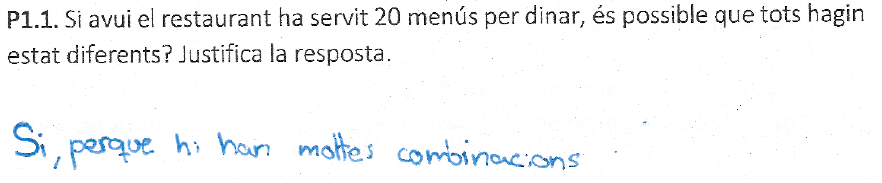
Figure 4. Incorrect answer of Q1. AC2 cognitive conflict (translation: yes, because there are a lot of combinations).